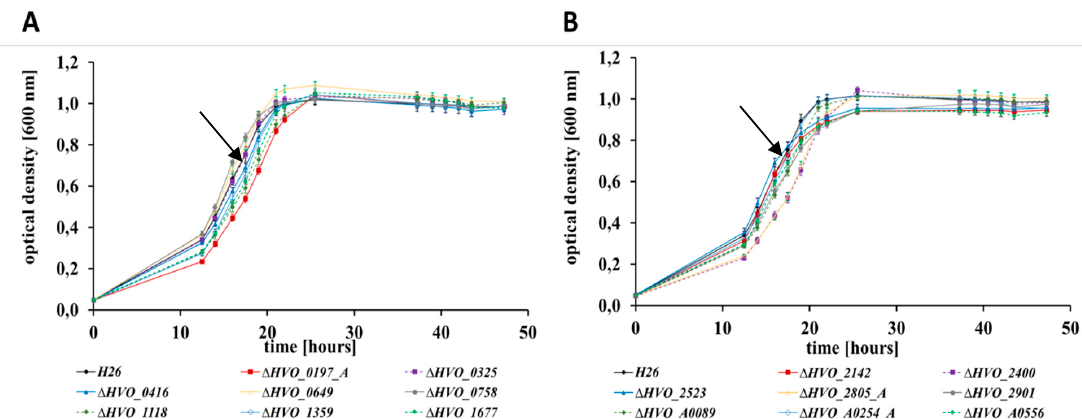
Figure 1. Growth curves of the parent strain H26 (black) and 16 deletion mutants (in color) grown in a complex medium. ( A ) Parent strain H26 (black) and the deletion mutants ∆ 0197_A (red), ∆ 0325 (purple), ∆ 0416 (dark blue), ∆ 0649 (yellow), ∆ 0758 (grey), ∆ 1118 (dark green), ∆ 1359 (light blue), ∆ 1677 (light green). ( B ) Parent strain H26 (black) and the deletion mutants ∆ 2142 (red), ∆ 2400 (purple), ∆ 2523 (dark blue), ∆ 2805_A (yellow), ∆ 2901 (grey), ∆ A0089 (dark green), ∆ A0254_A (light blue), ∆ A0556 (light green). The wild-type is indicated by black arrows.